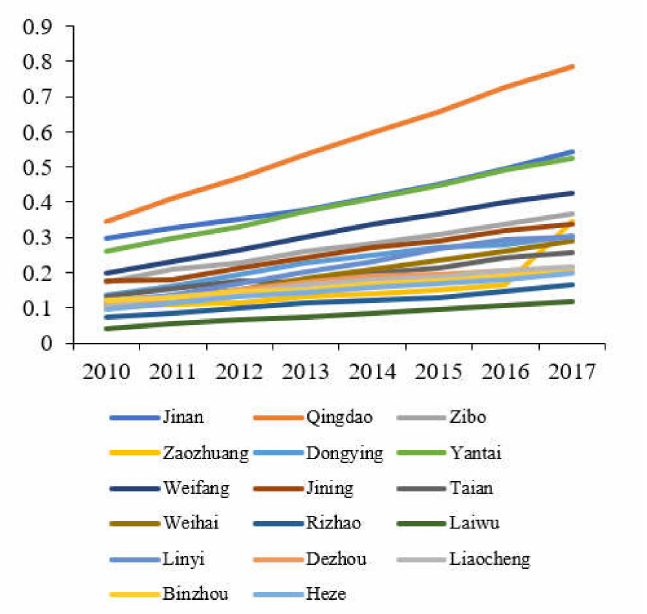
Figure 3. Evaluation value of the economic systems of cities in Shandong